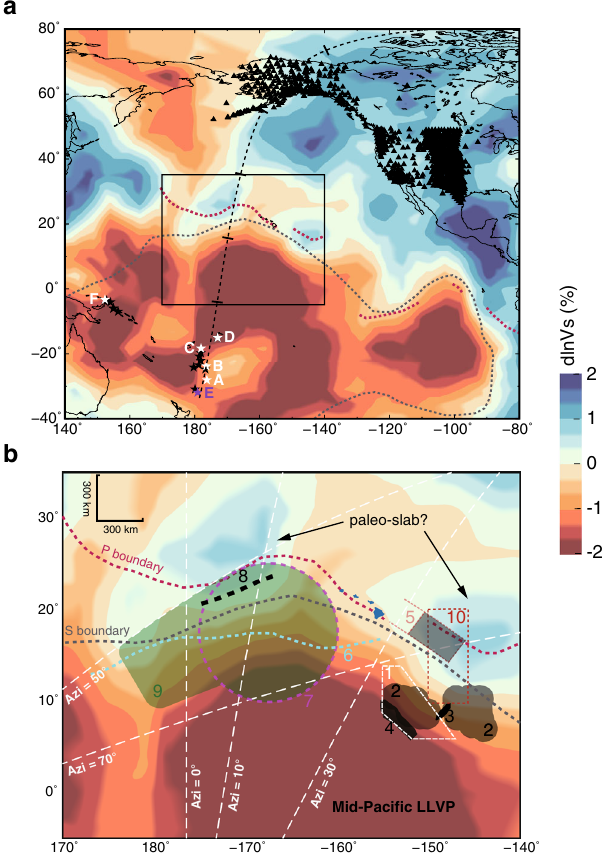
Fig. 1 Locations of events and stations used in this study. a Five events (A, B, C, D and F, white stars) and stations (black triangles) are used to model the seismic structure of the Paci fi c Large Low Velocity Province (LLVP) and ultra-low velocity zone (ULVZ) in detail. Event E (purple star) is used to correct S travel times (see text for details). A cross-section along the black dashed line with 20° tick interval is displayed in Fig. 3a. b Enlarged view of the inset box in a . The northern shear (S) wave 24 and compressional (P) wave boundaries 35 of the Paci fi c LLVP are indicated by grey and red dashed lines, respectively. The white dashed polygon 1 indicates an area of strongly varied D ʺ structure 55 . The shaded regions with corresponding fonts in color are inferred ULVZs: 2 54 , 3 27 , 4 26,55,62 – 65 , and 5 29 . The cyan dashed line 6 displays the ULVZ boundary inferred from a PKP study 28 . The magenta dashed circle 7 represents the Hawaiian mega- sized (HM) ULVZ 25 . The newly mapped LLVP boundary and the North Paci fi c (NP) ULVZ are marked with heavy black dashed line 8 and green shadow region 9, respectively. Red box 10 marks the base of the modeled Hawaiian plume 56 . The white dashed lines mark different azimuths for events B and F. The background tomography image is from the GyPSuM model 5 at the core-mantle boundary. Note there are high-velocity regions, which are related to the paleo-slab, situated at the northern and northeastern edge of the Paci fi c LLVP and D ʺ discontinuities are observed in these two regions 24,29